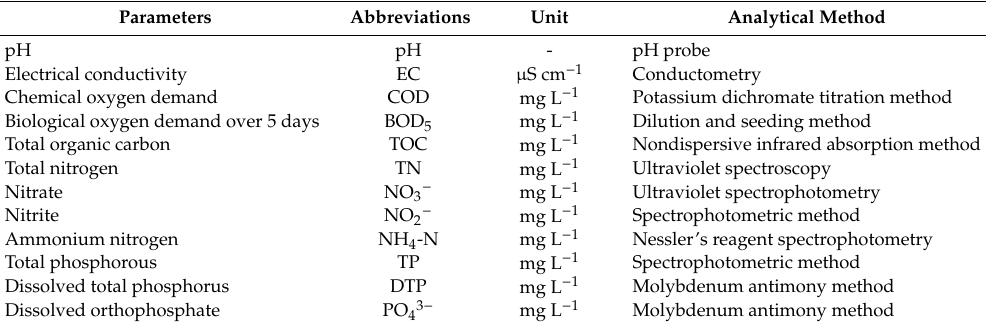
Table 1. The water quality parameters, their units and the associated analytical method.